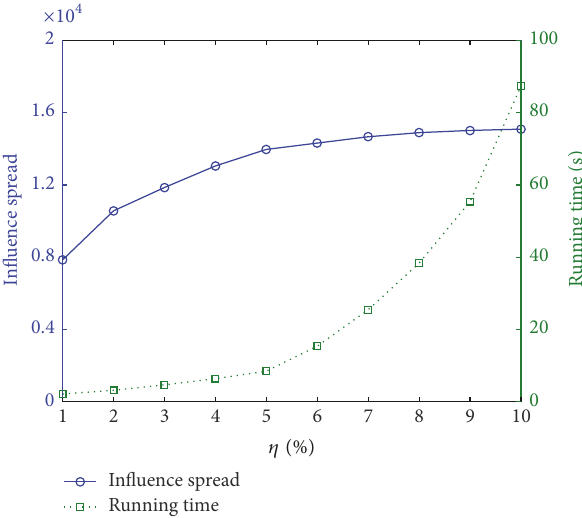
Figure 9: The effect of tuning of 𝜂 on running time and influence